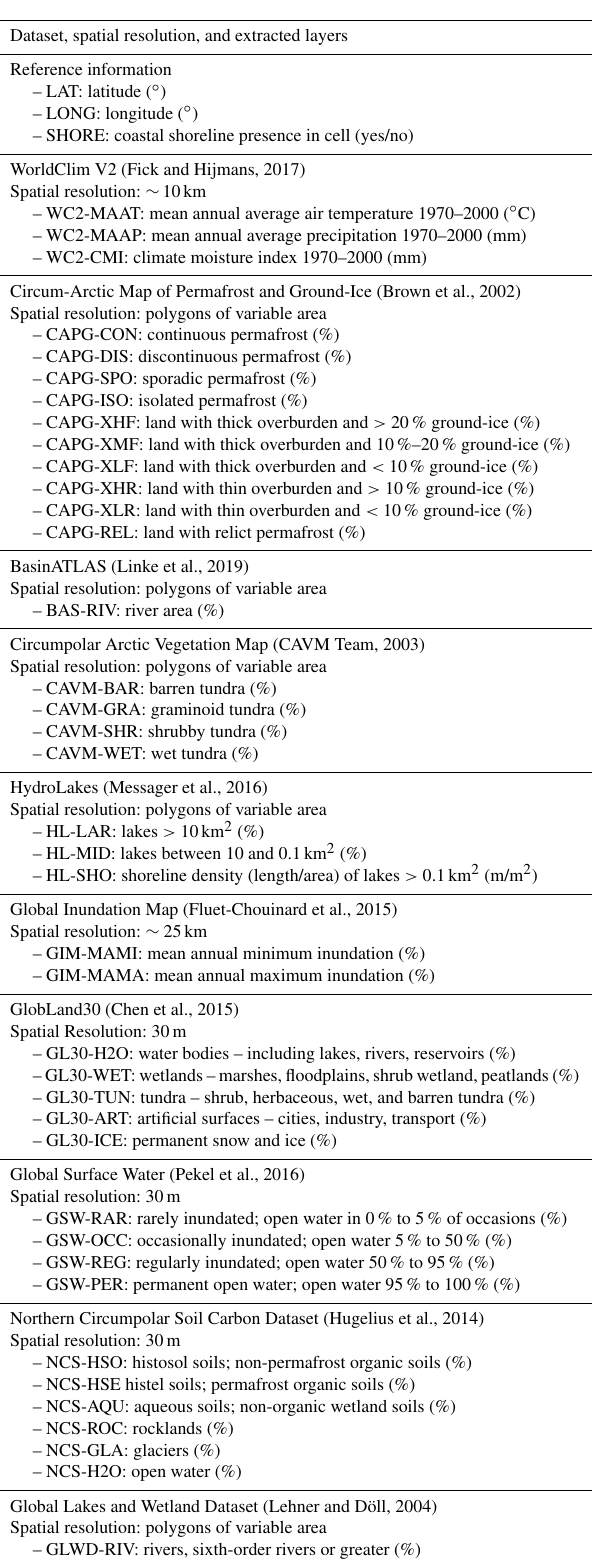
Table 1. Description of data sources and layers extracted into the BAWLD 0.5 ◦ grid cell